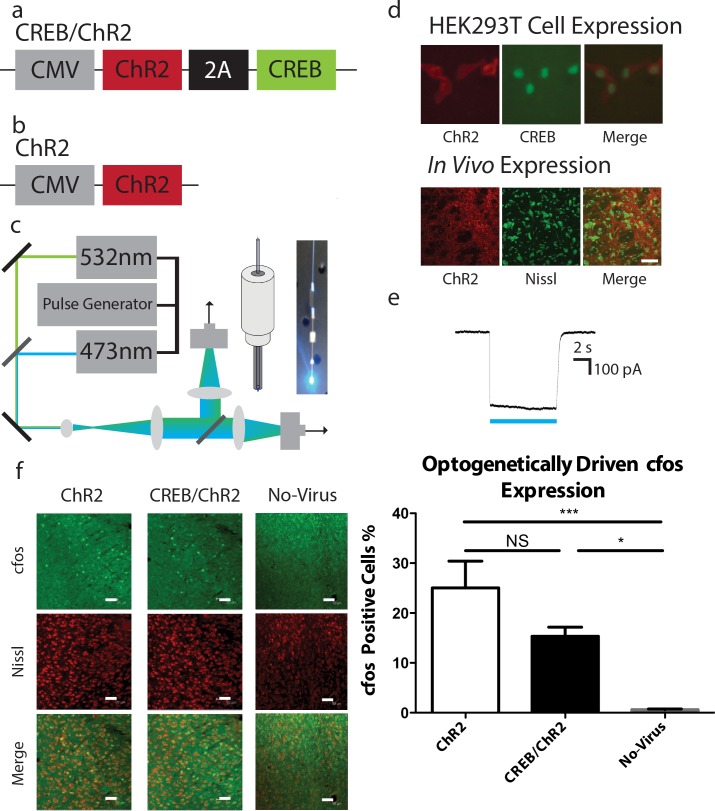
Viral design, optogenetic setup, expression, electrophysiological and molecular characterization of CREB/ChR2 and ChR2.(a) CREB/ChR2, (b) ChR2 and (c) Optogenetics setup. (d) Expression of CREB/ChR2 in HEK293T cells and in vivo. HEK293T cells were infected with CREB/ChR2 and the expression of CREB and ChR2 was visualized by EGFP and mCherry fluorescence respectively. Cells in vivo were stained for mCherry and are counterstained with Nissl. Scale bar, 50um. (e) Whole-cell recordings from CREB/ChR2 expressing HEK293T. Inward depolarizing currents were observed during 473nm light illumination. (f) The LA of CREB/ChR2 (n = 5) and ChR2 (n = 7) expressing animals was illuminated with 473nm light while another cohort of control animals also received 473nm light illumination, but expressed no opsin (No-Virus, n = 6). The animals were sacrificed and their brains were stained for cfos. There was a significant difference in cfos expression between cohorts (one-way ANOVA, F(2,15) = 11.46, p < 0.001). Tukey’s HSD post hoc test determined CREB/ChR2 (p < 0.05) and ChR2 (p < 0.001) cohorts had a higher proportion of cfos positive neurons compared to the No-Virus cohort. The percent of cfos positive cells represents the fraction of cfos positive neurons over the total number of neurons as counted by nissl staining. ChR2; 25.05 ± 5.36%, CREB/ChR2; 15.33 ± 1.83%, No-Virus; 0.58 ± 0.14%. Error bars are mean ± SEM, * = p < 0.05, *** = p < 0.001, NS = not significant.